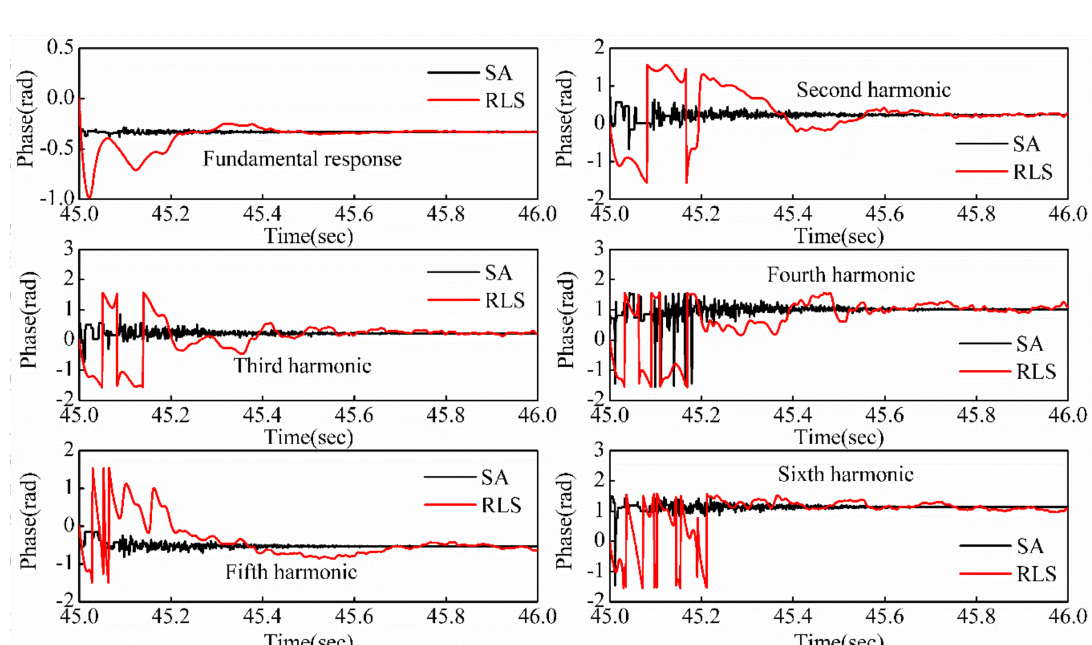
Figure 11. Estimation of amplitude.